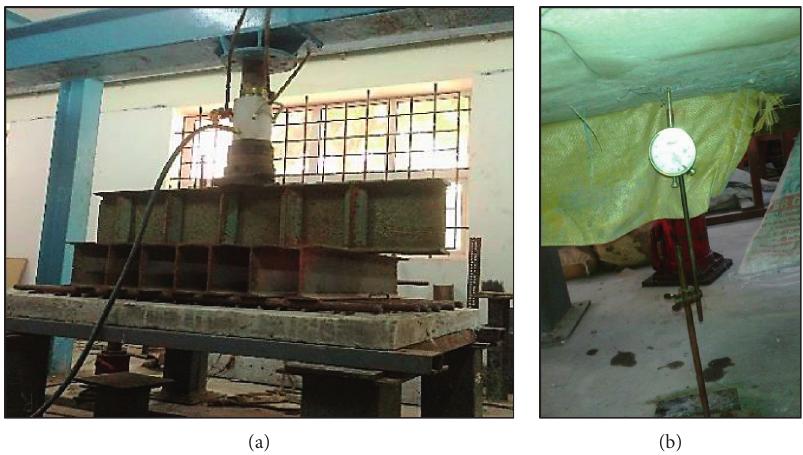
Figure 4: (a)Test setup of the slab under a loading frame. (b) LVDT at the middle of slab.